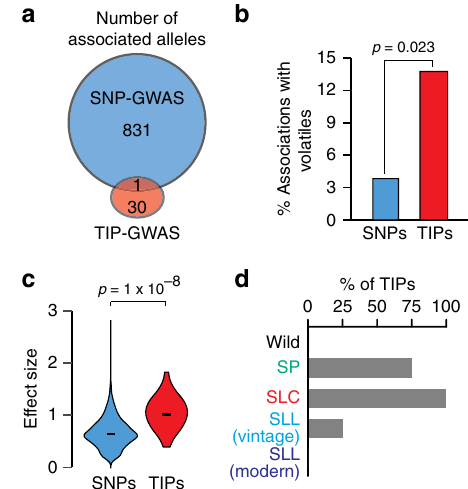
Fig. 4 TIP associations with secondary metabolism. a Signi fi cant associations detected by SNP- and TIP-GWAS and their overlap. b Percen- tage of identi fi ed loci associated with variation in volatiles. Statistical signi fi cance for differences was obtained using a two-sided Fisher test. c Effect size for association signals detected in SNP- and TIP-GWAS. Statistical signi fi cance for differences was obtained using a two-sided MWU test. d Percentage of TIPs with signi fi cant associations present within each of the fi ve tomato groups. Source data of Fig. 4a, b, d are provided as a Source Data fi